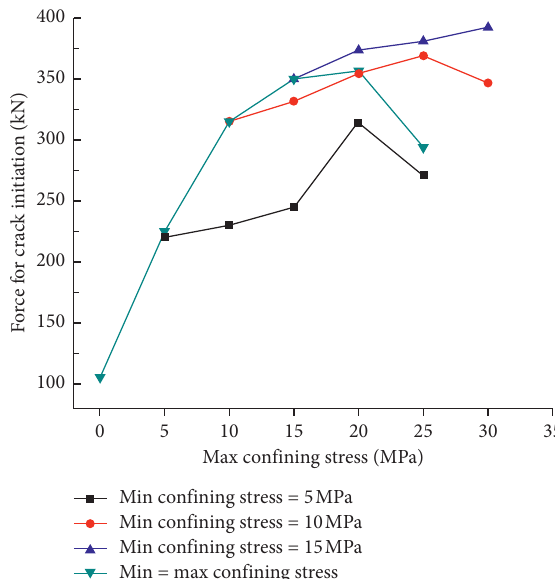
Figure 17: Thrust force for crack initiation with the different confining stress levels (marble samples) [28].